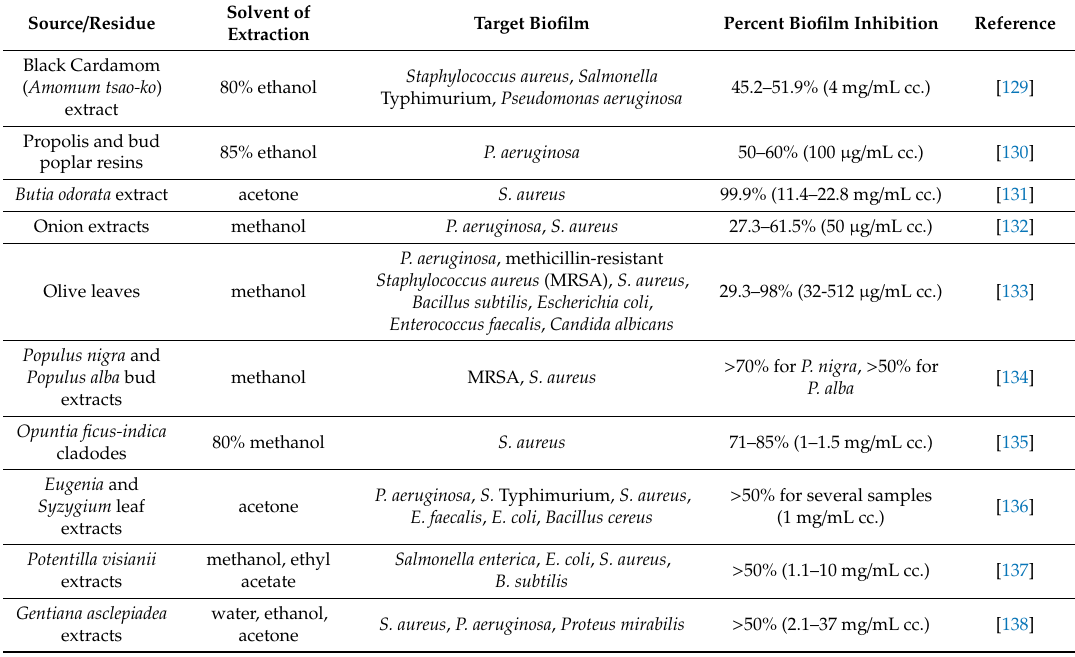
Table 4. Antibiofilm activity of plant extracts against food pathogen microorganisms, examples from recent